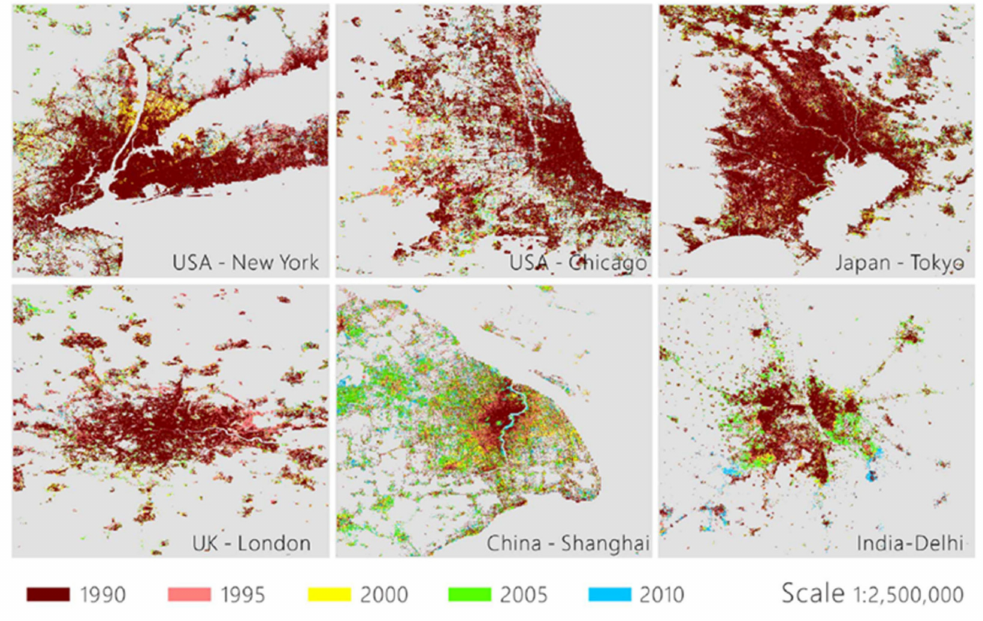
Figure 11. Urban land expansion from 1990 to 2010 in the representative cities. Source: [87].